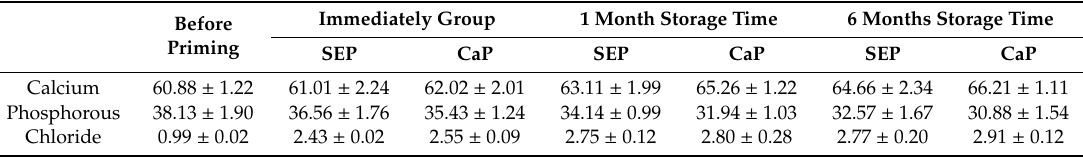
Table 3. The mean value of rate (%) of elemental composition before priming and at each storage time point after priming (immediately,1 month, and 6 months).